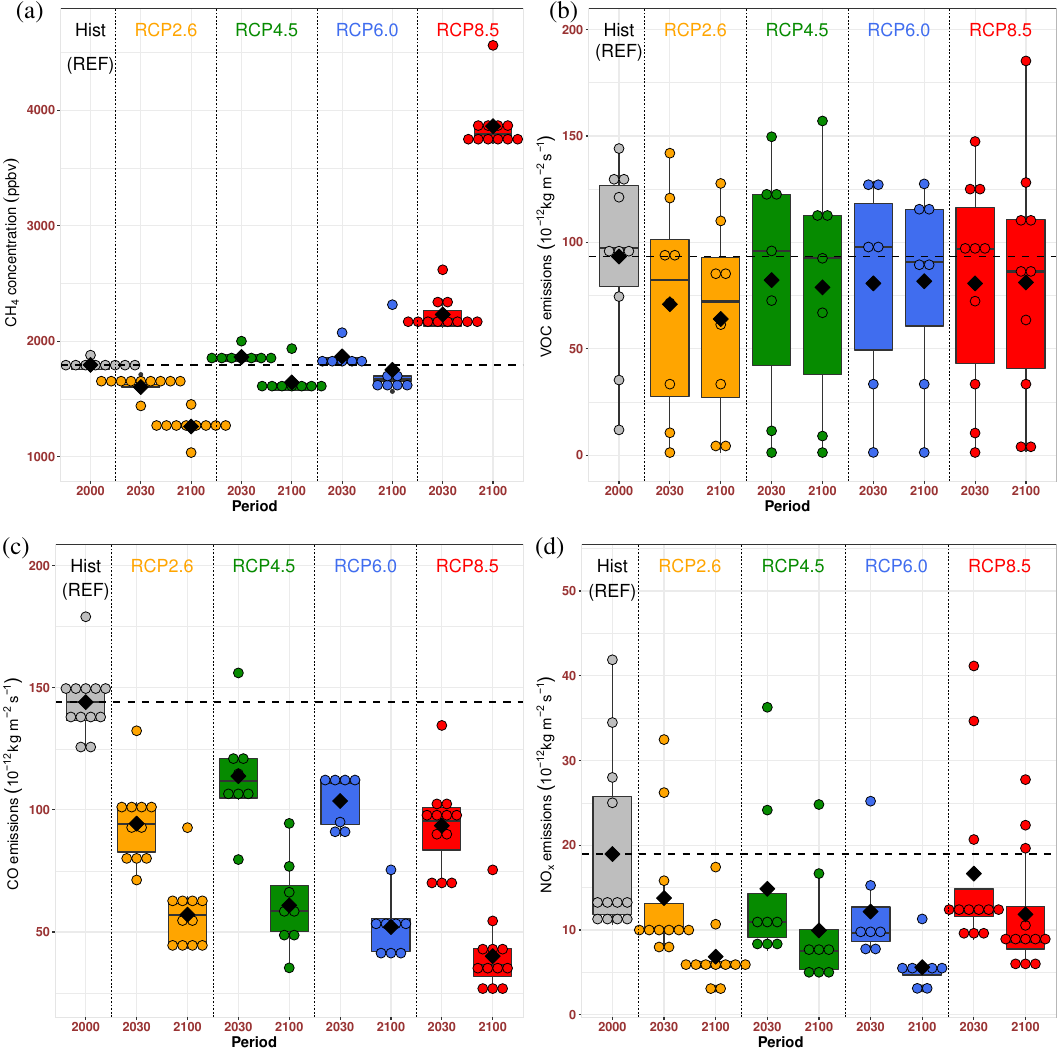
Figure 7. Same as Fig. 6 but for (a) the surface CH 4 concentrations and emissions of ozone precursors: (b) VOCs, (c) CO and (d) NO x . ranean region. For RCP2.6, the surface ozone mean de- creases between 2000 and 2030 over the Mediterranean re- gion ( − 5 ppbv), with a minimum in southern Europe mainly in Italy ( − 11 ppbv). An increase is observed in the north- west of Europe ( + ppbv). However, over the period 2030– 2100, the surface ozone decreases significantly over the Mediterranean region ( − 11 ppbv) and specifically over the Mediterranean Sea and the eastern part of the Atlantic Ocean ( − 18 ppbv). Over the period 2000–2100, the surface ozone decreases significantly on average by − 16 ppbv. For RCP4.5, from 2000 to 2030, the ozone decrease is restricted to Eu- rope and the Mediterranean Sea with an ozone increase over north Africa and the eastern part of the Atlantic Ocean, reaching a maximum of + 2.5 ppbv unlike RCP2.6. Surface ozone remains generally constant over the Mediterranean